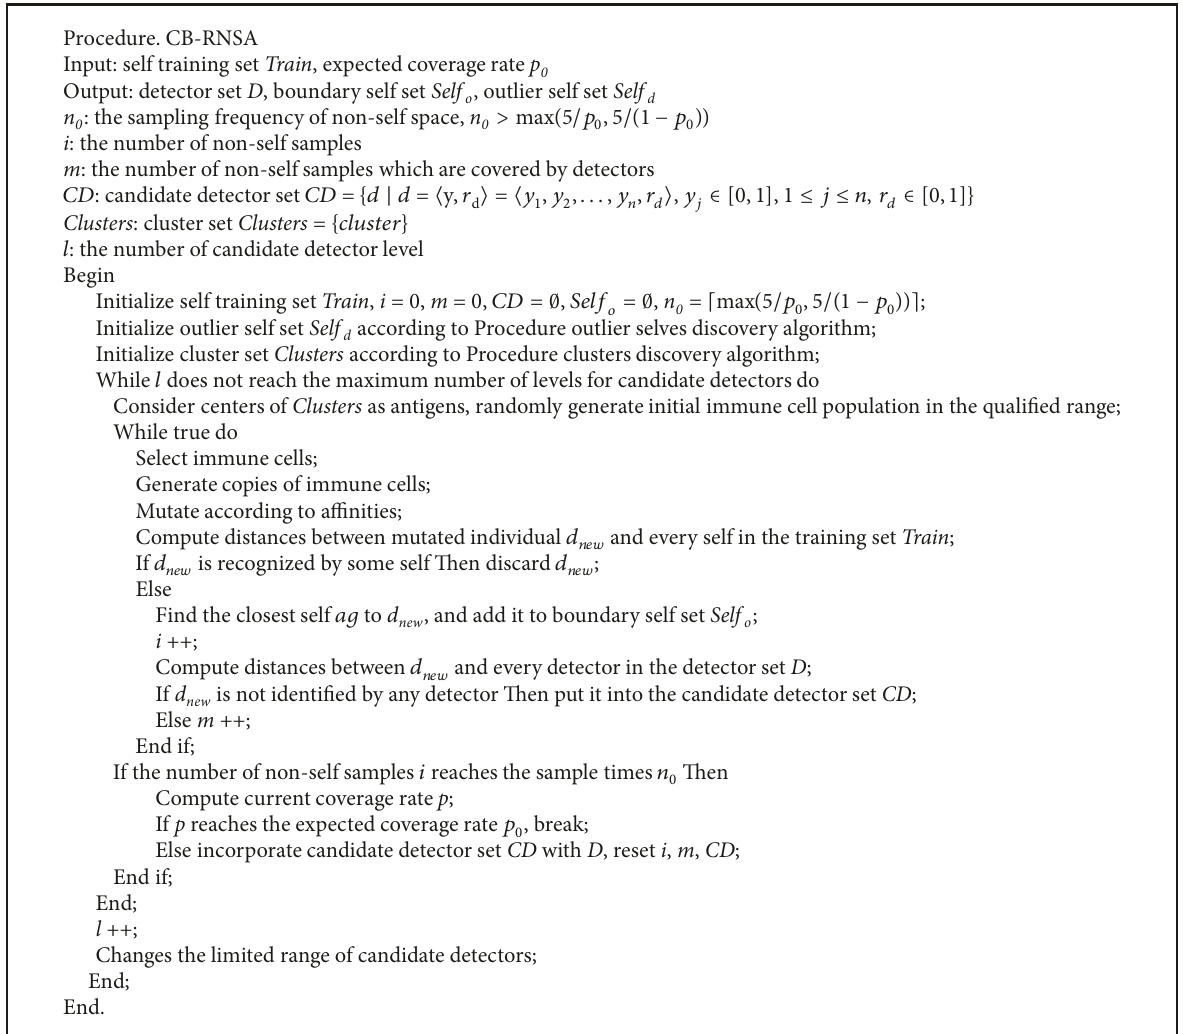
Algorithm 3: The process of CB-RNSA.